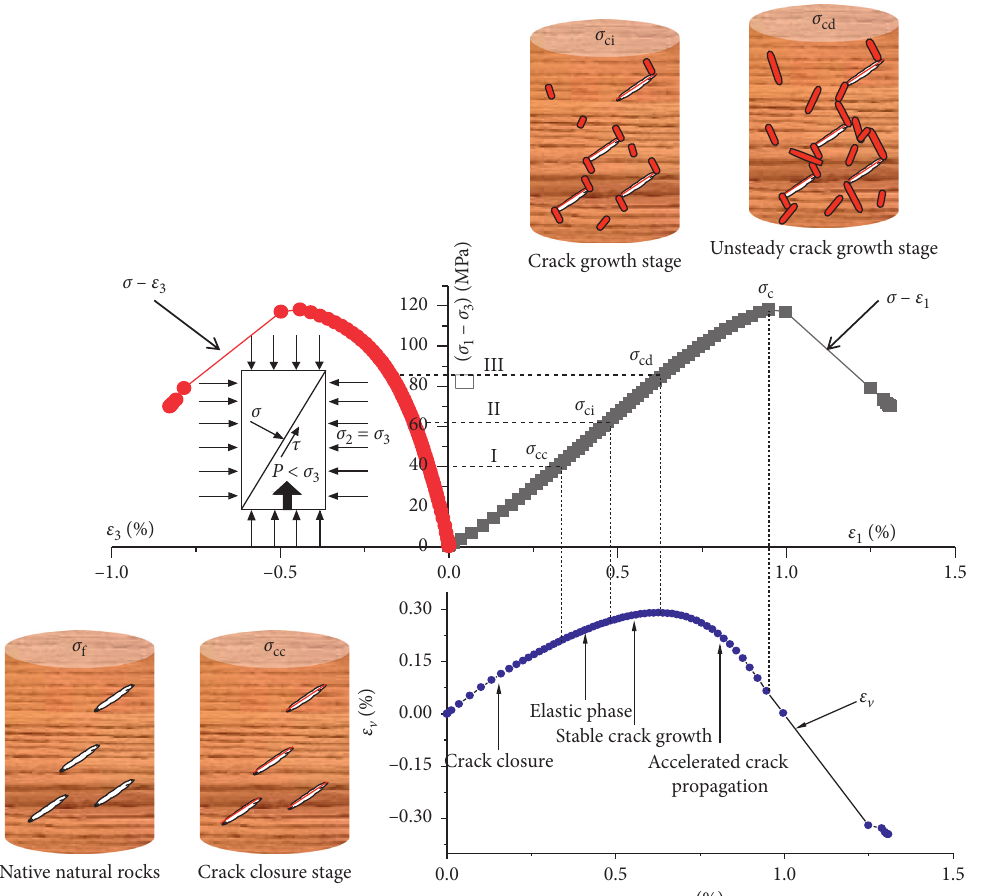
Figure 5: Crack initiation stress and initiation propagation and schematic